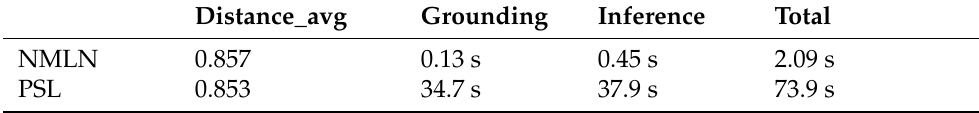
Table 3. Evaluation results on mobile phone ranking. NMLN, Numerical Markov Logic